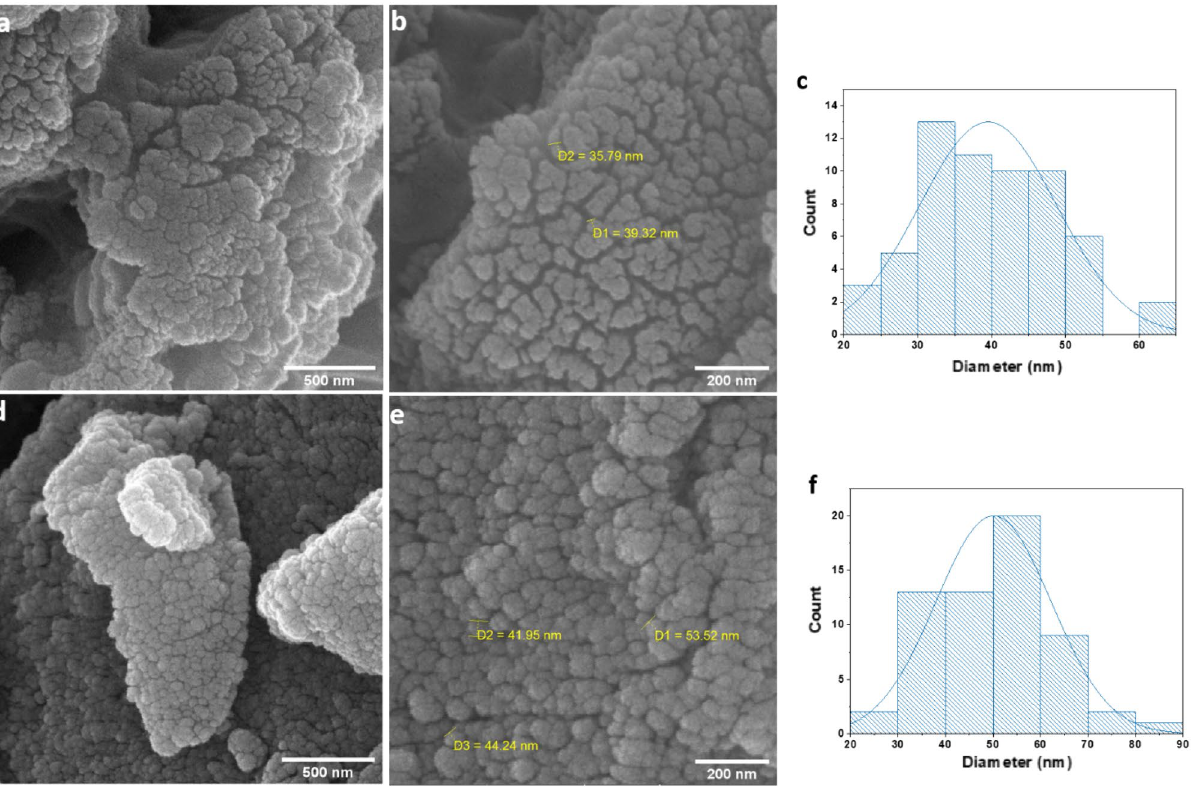
Figure 3. ( a and b ) FESEM images of ZnFe 2 O 4 and ( c ) ZnFe 2 O 4 particle size distribution and ( d and e ) FESEM images of ZC and ( f ) ZC particle size distribution.